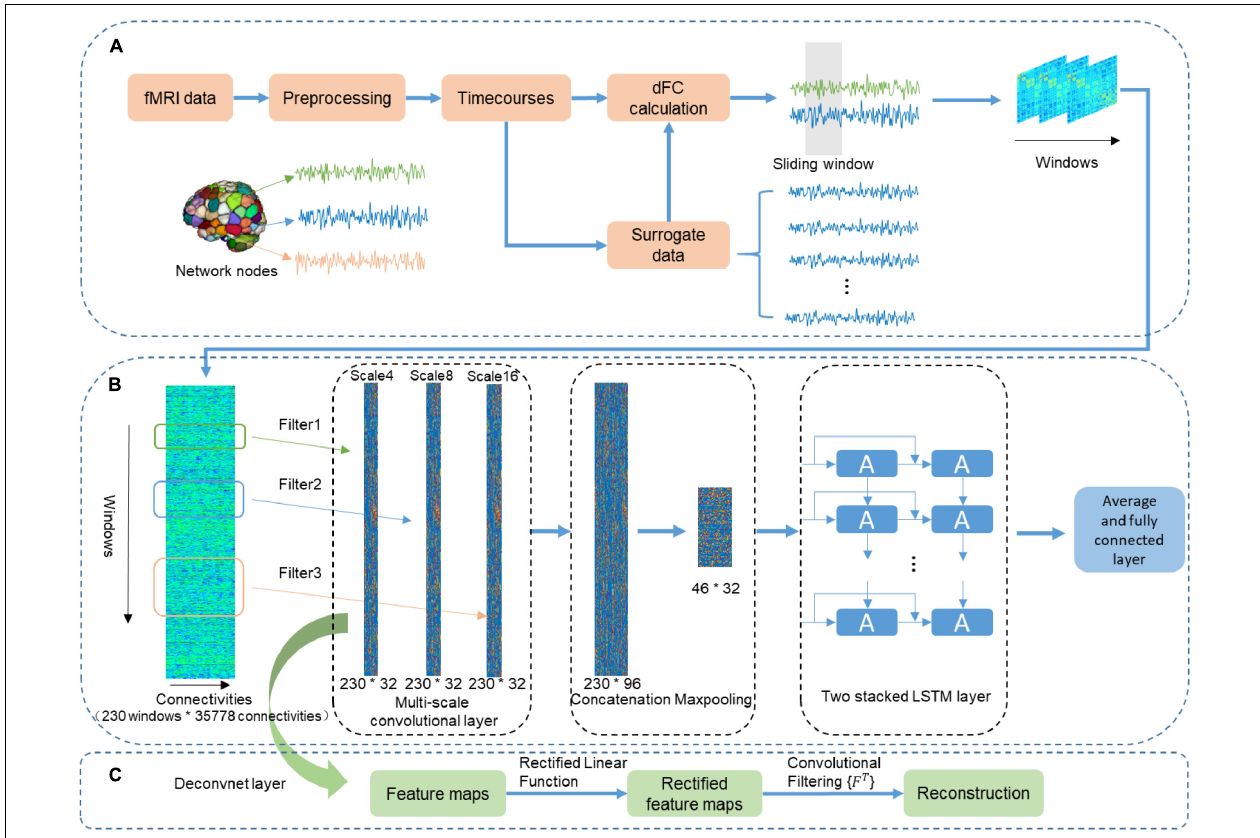
FIGURE 1 | The flowchart of using the CNN + LSTM model to distinguish sex and predict intelligence based on dynamic functional connectivity (dFC). (A) The pipeline of calculating dFC using resting-state fMRI data and surrogate data that was generated by employing the multivariate phase randomization (MVPR) model on original BOLD signals. (B) Overview of multi-layer structure in the CNN + LSTM model. (C) The deconvolutional computation for visualizing learned spatiotemporal features in dFC from the Conv1D